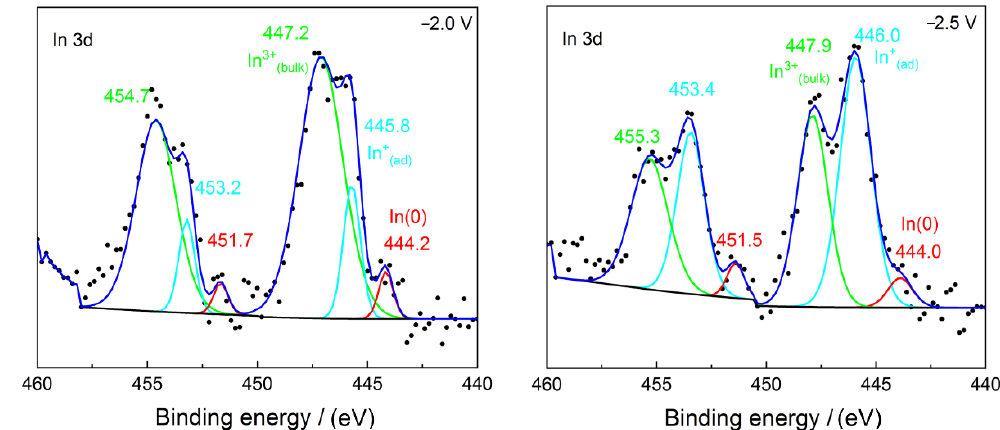
Figure 8. Deconvolution of the in situ XPS In 3d spectra at − 2.0 V and at − 2.5 V.